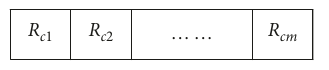
Figure 2: The historical